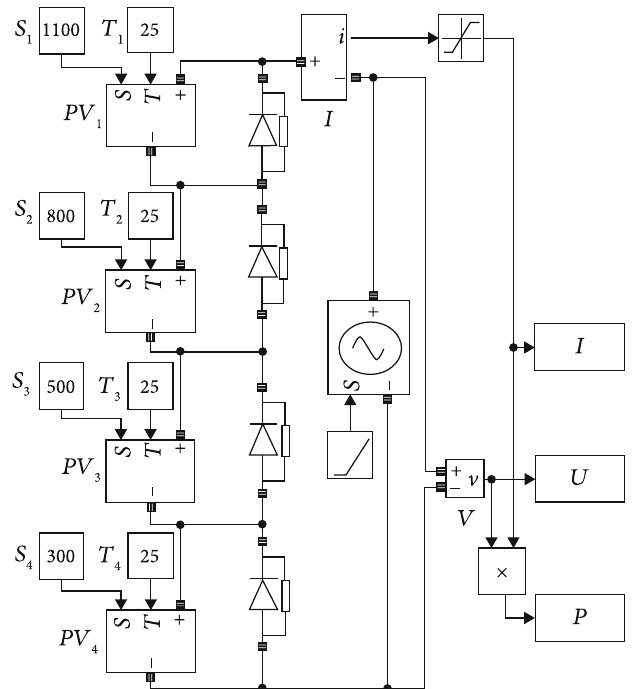
Figure 14: PV simulation model under local shading.